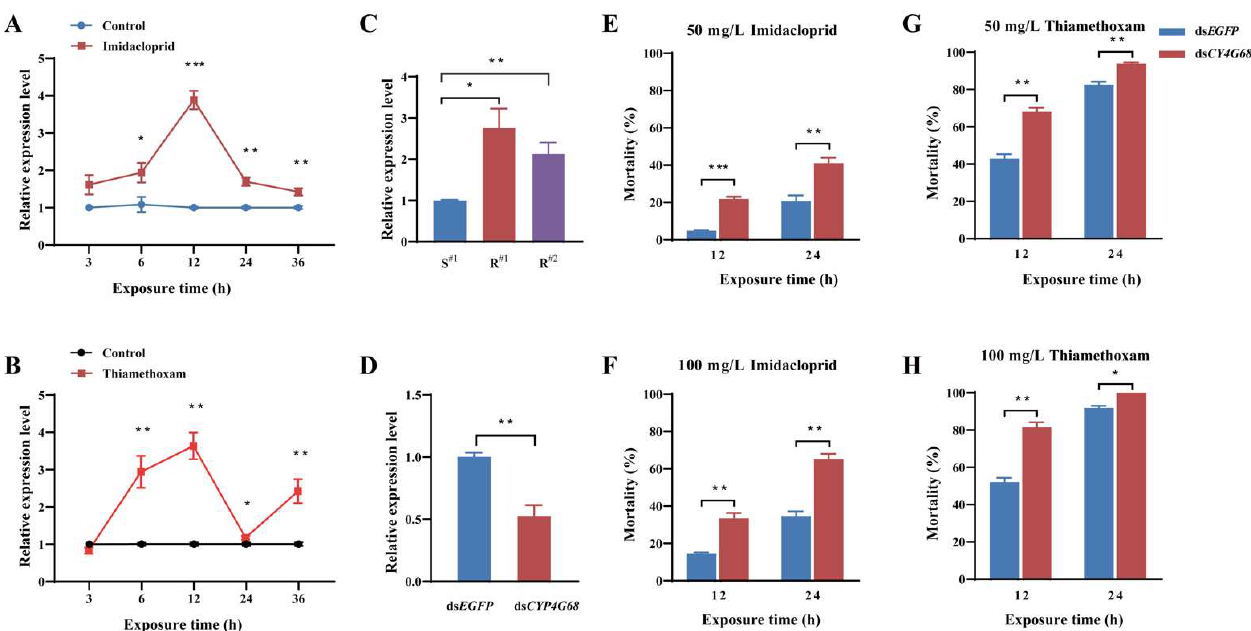
Figure 4. Functional analysis of CYP4G68 in laboratory strains. ( A , B ) Relative expression of CYP4G68 in B. tabaci adults after exposure to imidacloprid ( A ) and thiamethoxam ( B ). ( C ) Relative expression of CYP4G68 in resistant and susceptible adults. ( D ) Relative expression of CYP4G68 in B. tabaci adults fed ds CYP4G68 for 48 h. ( E – H ) Mortality of the imidacloprid-resistant strain (R #1 , E , F ) and thiamethoxam-resistant strain (R #2 , G , H ). Values are the means ± SEM ( n = 3), with asterisks representing significant differences between the treatments and the control (* p < 0.05, ** p < 0.01, *** p <